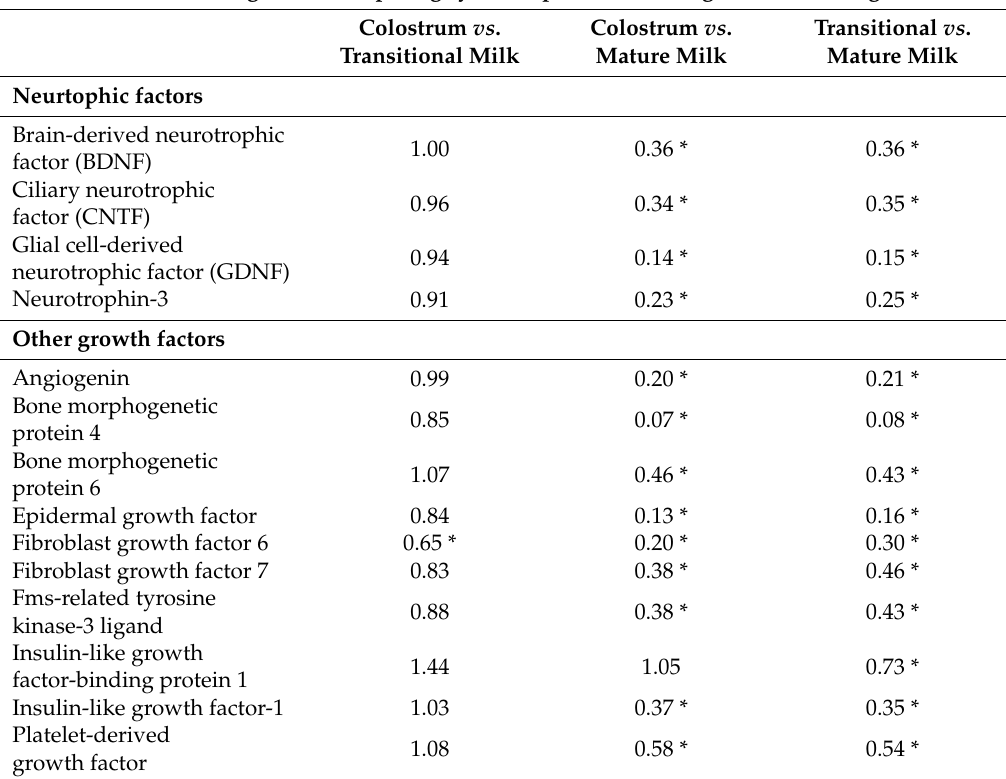
Table 2. Fold change table comparing cytokine profile according to lactation stage and gestational age. A: Fold change table comparing cytokine profile according to lactation stage Colostrum vs . Colostrum vs . Transitional vs . Transitional Milk Mature Milk Mature